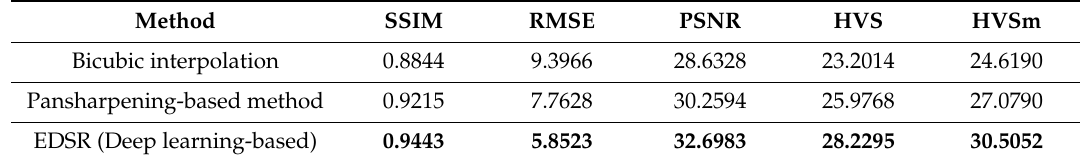
Table 2. Performance metrics for the enhanced left camera images with the ground truth left camera image as the reference image (the grayscale versions of the images are used in computing SSIM and RMSE). Bold format indicates the method providing better